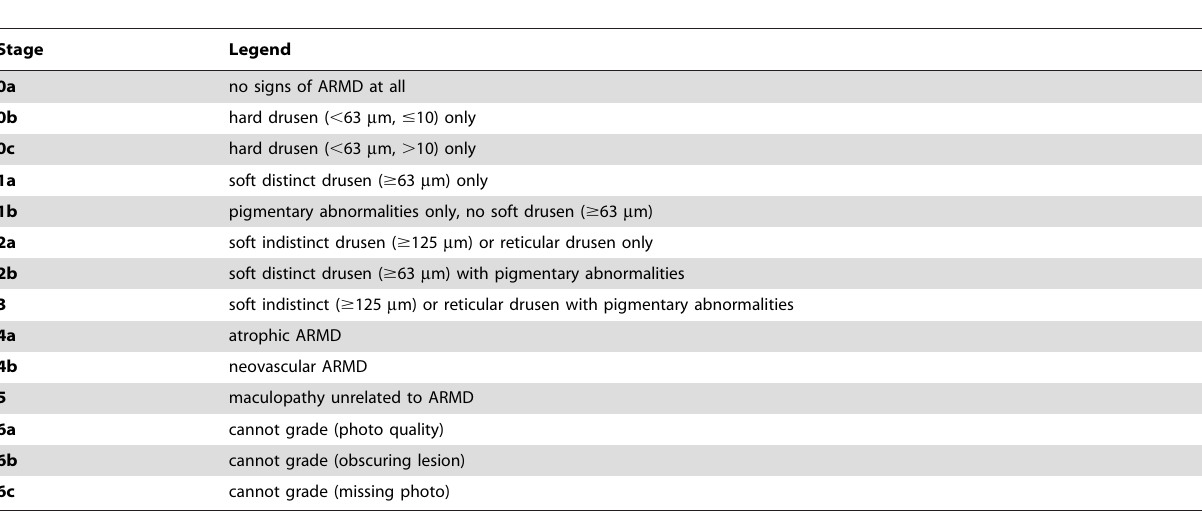
Table 3. Classification of stages of age-related macula degeneration (ARMD).